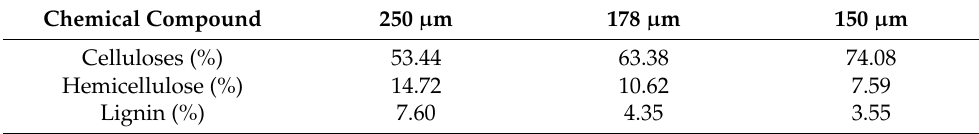
Table 1. Content of cellulose extracted from different particle sizes of Neosinocalamus affinis powder.